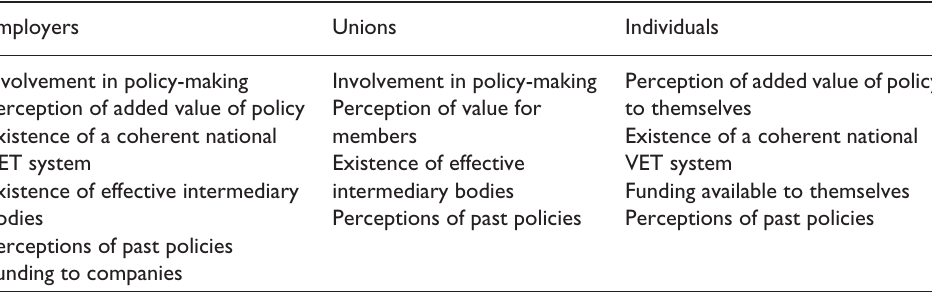
Table 1. Factors affecting whether major participating groups find training policies acceptable and